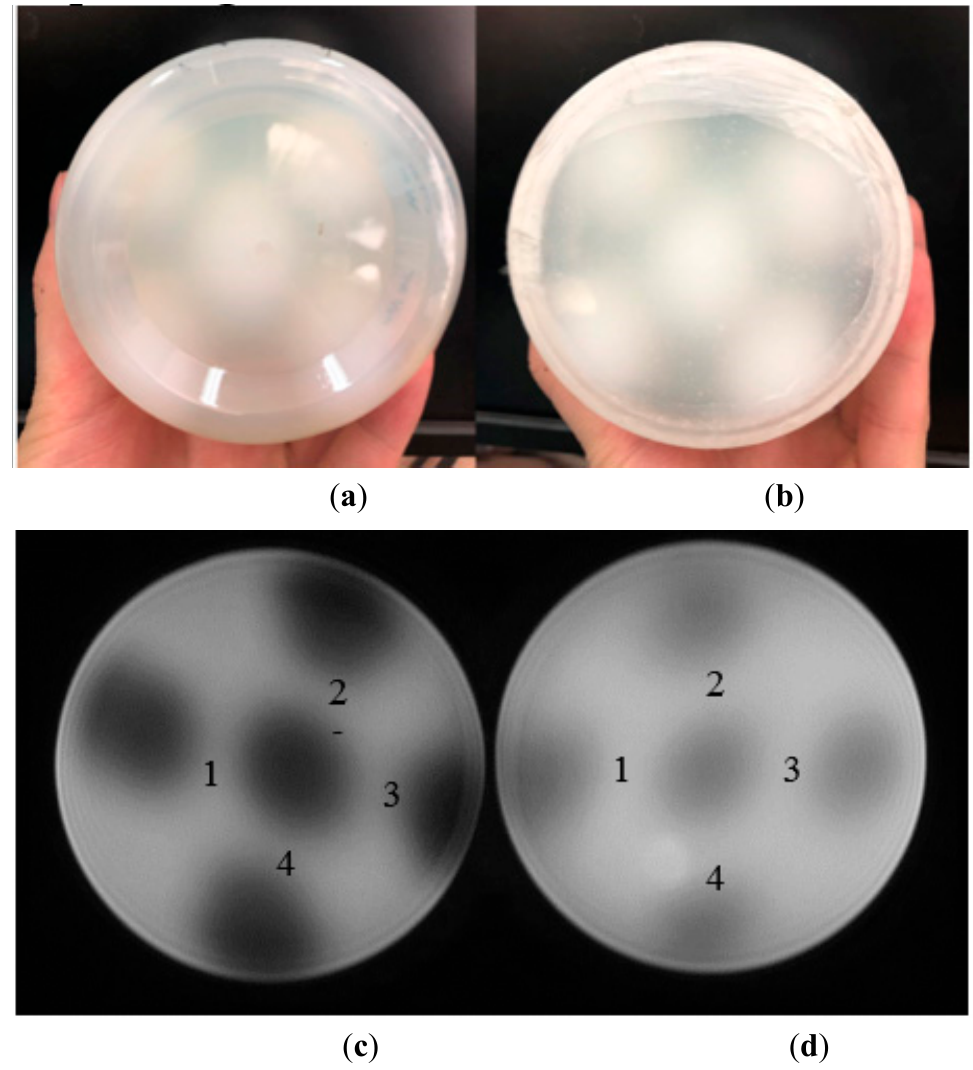
Figure 5. ( a ) MAGAT-f gel and ( b ) PAGAT gel after 73.5 MeV proton irradiation. VISTA map of ( c ) MAGAT-f and ( d ) PAGAT gel dosimeter. (No. 1–4 in Figure 5c,d demonstrate the spot spacing numbers measured by MAGAT-f and PAGAT gel dosimeter).